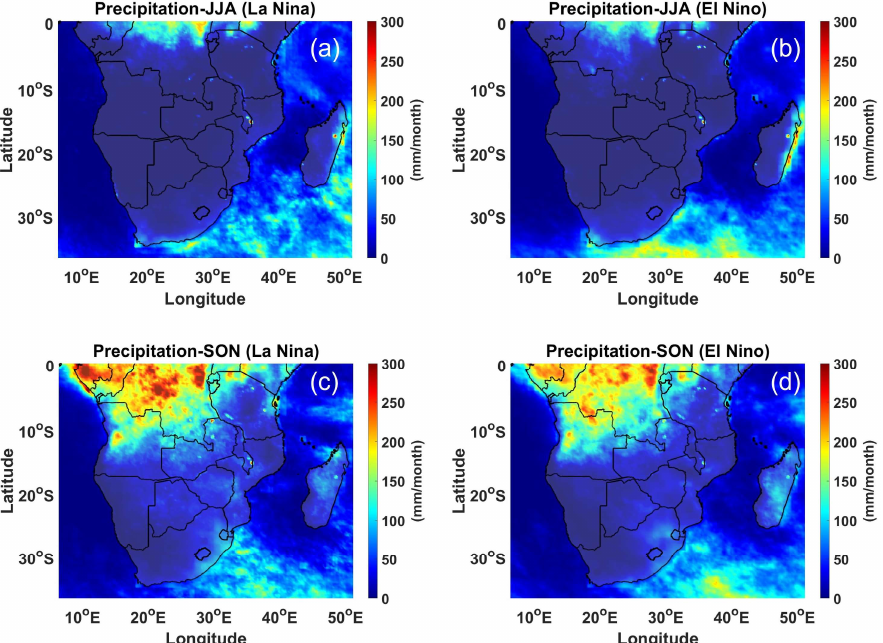
Figure 10. Spatial distribution of precipitation for the JJA ( a , b ) and SON ( c , d ) seasons during the La Niña ( a , c ) and El Niño ( b , d ) events.